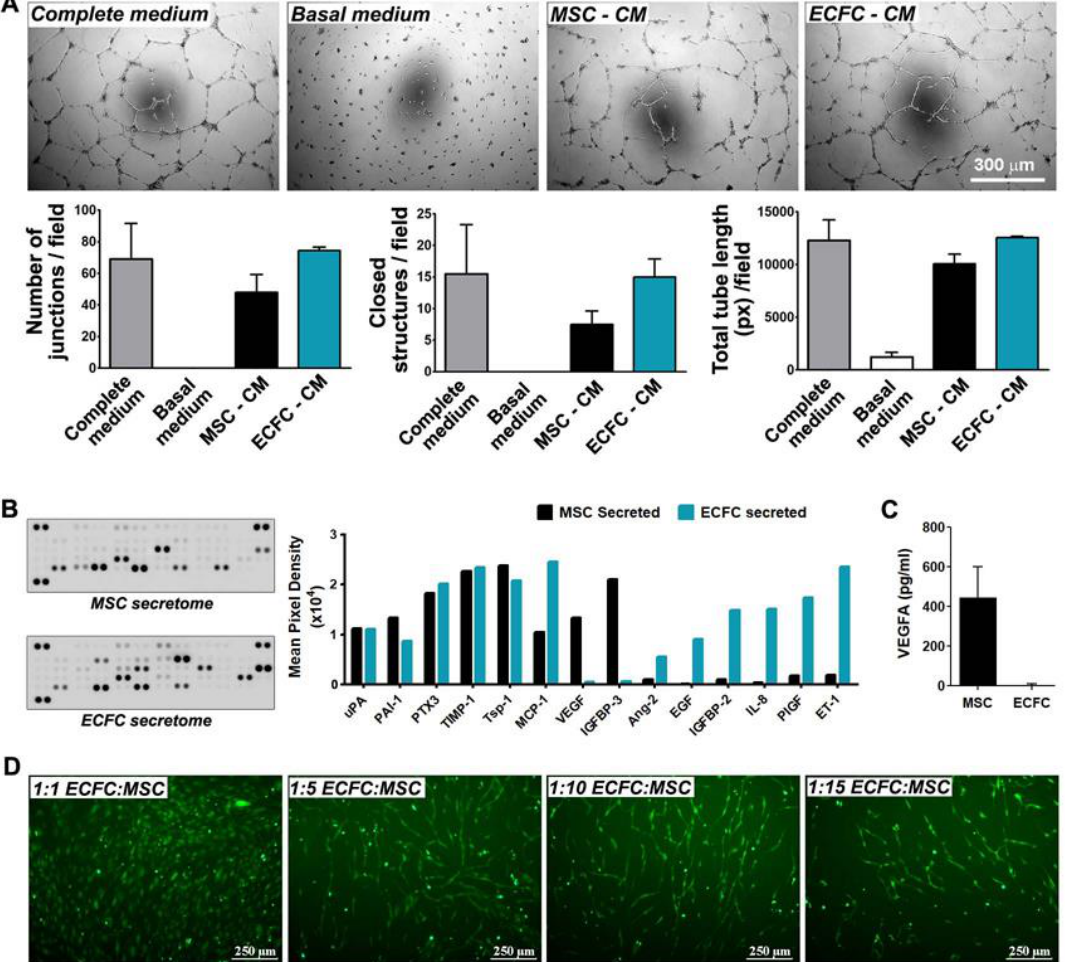
Figure 2. Angiogenic effects of MSC and ECFC. ( A ) Phase-contrast microscopy images showing vascular networks of endothelial cells assembled on Matrigel in the presence of MSC- and ECFC-CM. The diagrams illustrate comparable effects of the MSC- and ECFC-CM in terms of the number of junctions, total tube length, and closed structures formed by endothelial cells in one representative experiment performed in duplicates; ( B ) proteomic screening of cytokines secreted by MSC and ECFC in vitro, as assessed by Human Angiogenesis Proteome Profiler array; ( C ) ELISA quantification of VEGF in MSC and ECFC secretomes; ( D ) tube-like structures formed by fluorescent ECFC when co-cultured with unlabeled MSC in different cell ratios.